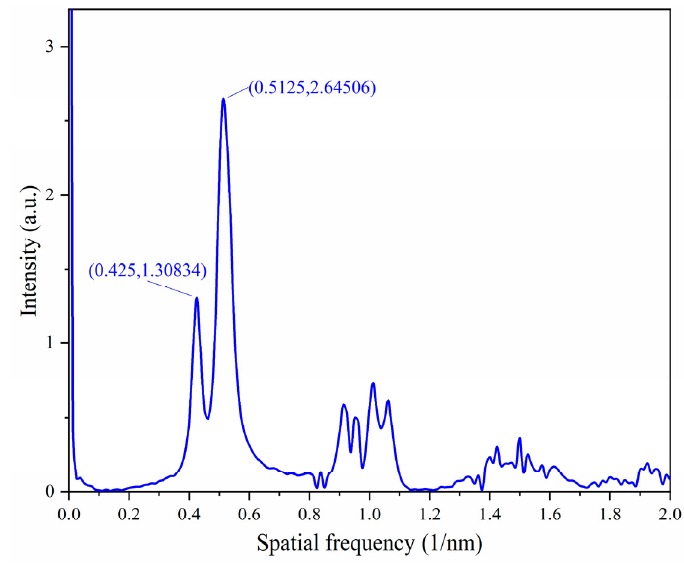
Figure 3. FFT of the reflection spectrum.